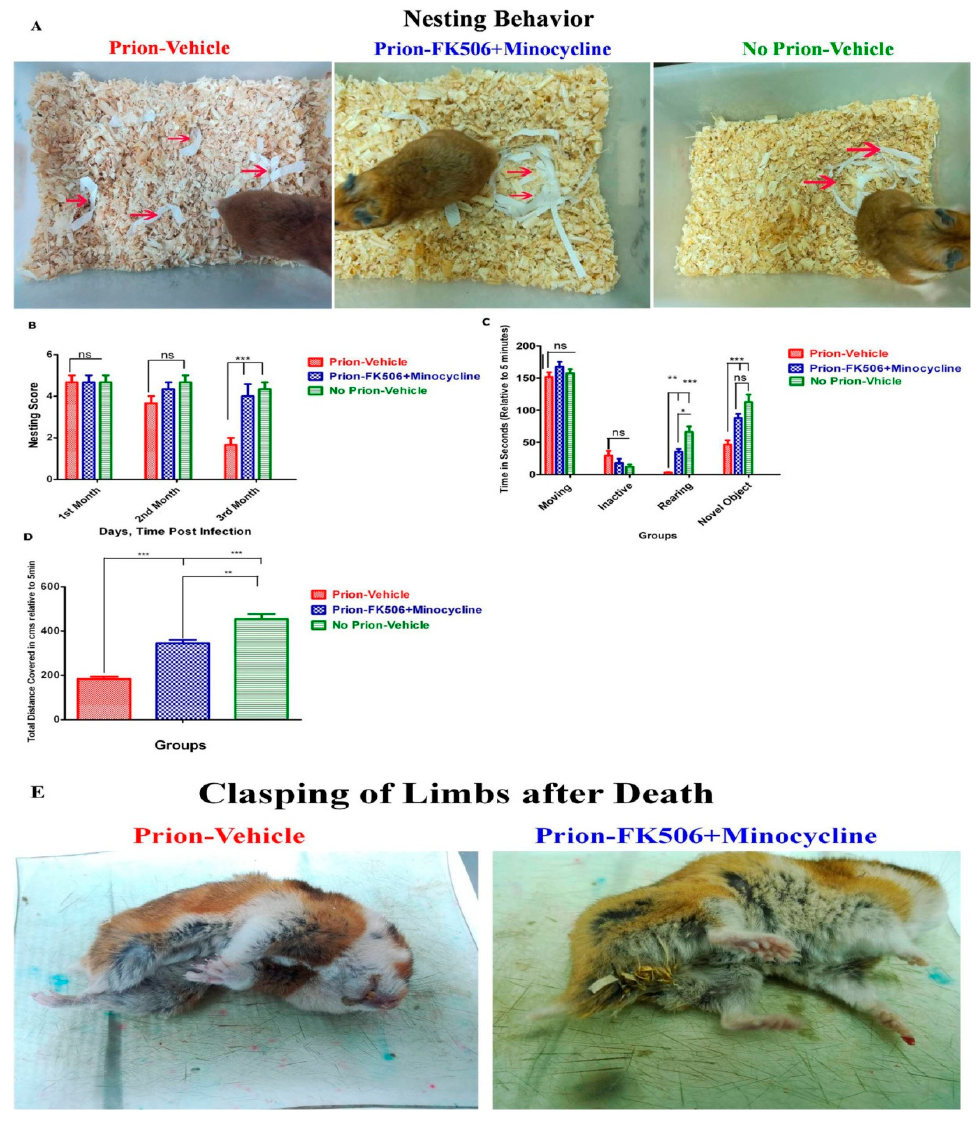
Figure 2. FK506+minocycline treatment enhanced nesting behavior, locomotor function and novel object finding in prion infected hamsters ( A ) Pictures showing the nesting behavior observed